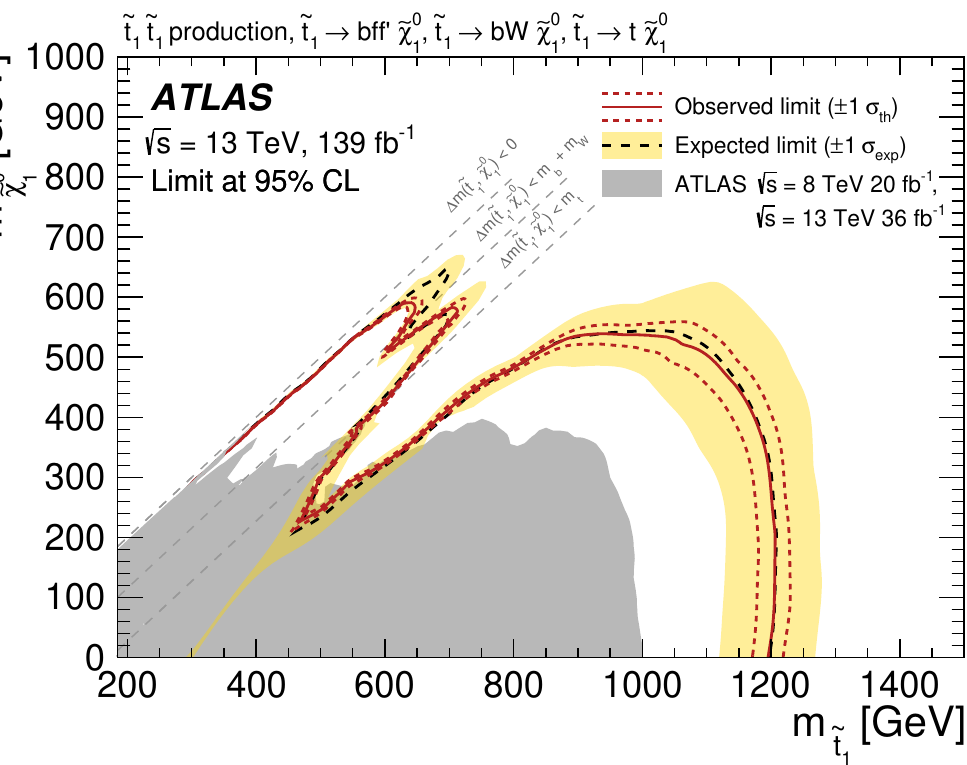
Figure 13. Expected and observed 95% CL excluded regions in the plane of m direct stop pair production assuming either a ˜ t 1 → t + ˜ χ 0 1 , ˜ t 1 → bW ˜ χ 0 1 or ˜ t 1 → bff 0 ˜ χ 0 1 decay with a branching ratio of 100%. The excluded regions from previous publications [29–31, 137] are shown by the shaded area and include additional topologies. The diagonal dashed lines indicate the kinematical border of the stop decay